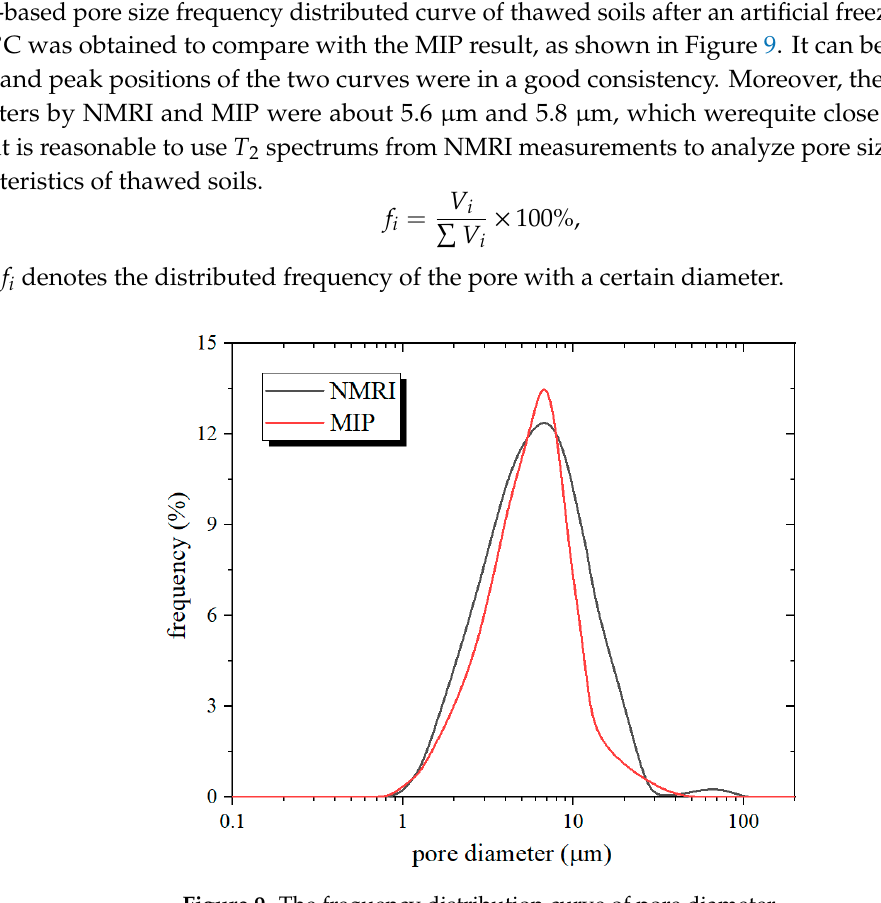
Figure 9. The frequency distribution curve of pore diameter.